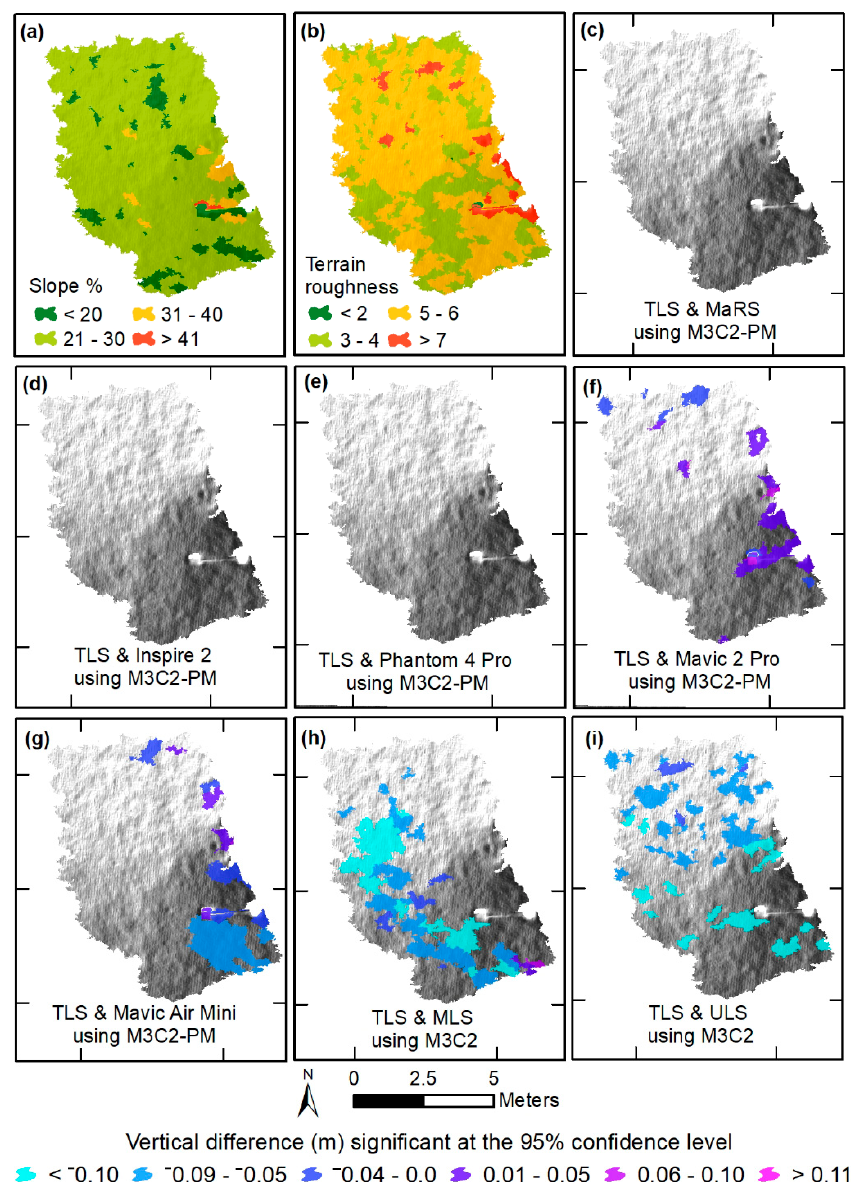
Figure 7. Object-based mean vertical differences of the original point clouds significant at the 95% confidence level between (1) TLS and SfM-based surveys using the M3C2-PM algorithm ( c – g ), and (2) TLS and MLS ( h ), and TLS and ULS ( i ) using the M3C2 algorithm, all in meters. Object-based slope was determined using the TLS ( a ), and terrain roughness was determined using the standard deviation of the slope derived from the TLS ( b ). All objects are overlying a hill shade image.